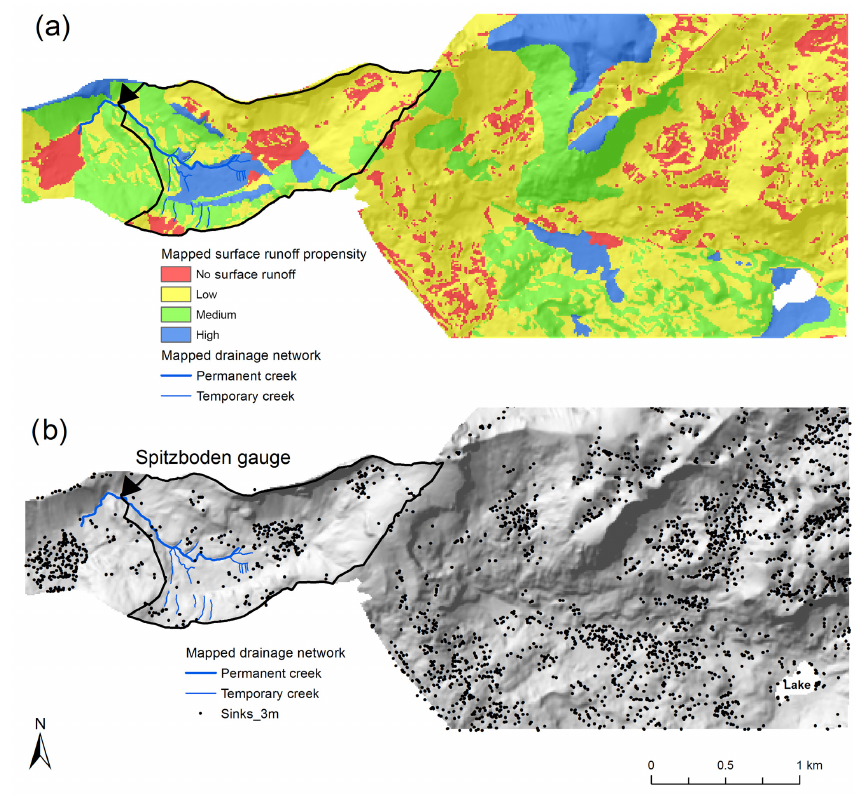
Figure 6. Comparison of the surface runoff propensity index (a) with sink holes (b) . Sink holes have been automatically generated from the lidar terrain model at 3m resolution. Shading represents topography from the 1m terrain model. Black polygon shows the topographic catchment of the Spitzboden stream